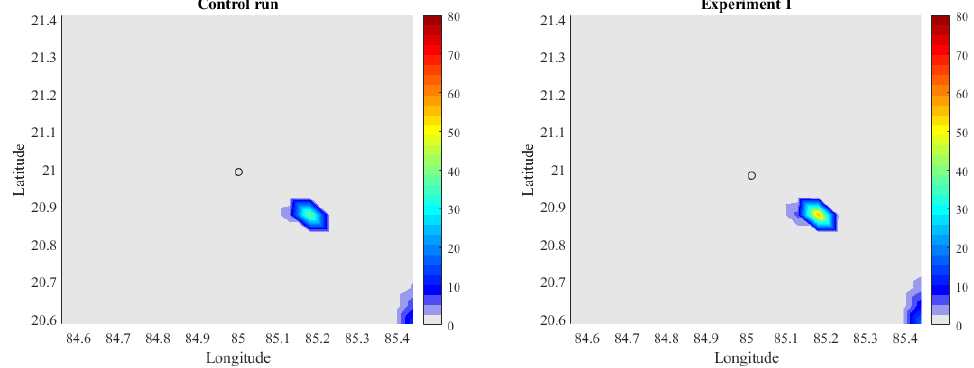
Figure 5. Rain rate (mm/h) comparisons on 16 August 2008 for WDM6 at near-surface level.